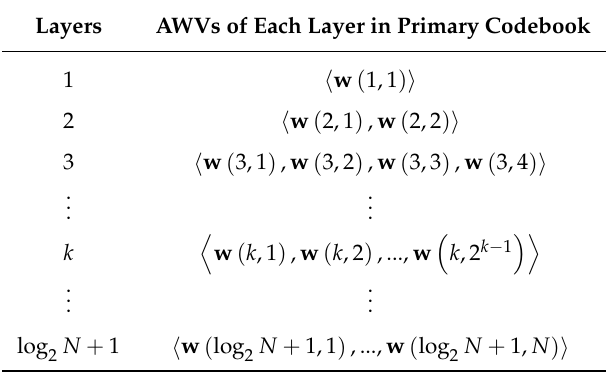
Table 2. Layered primary codebook design. Layers AWVs of Each Layer in Primary